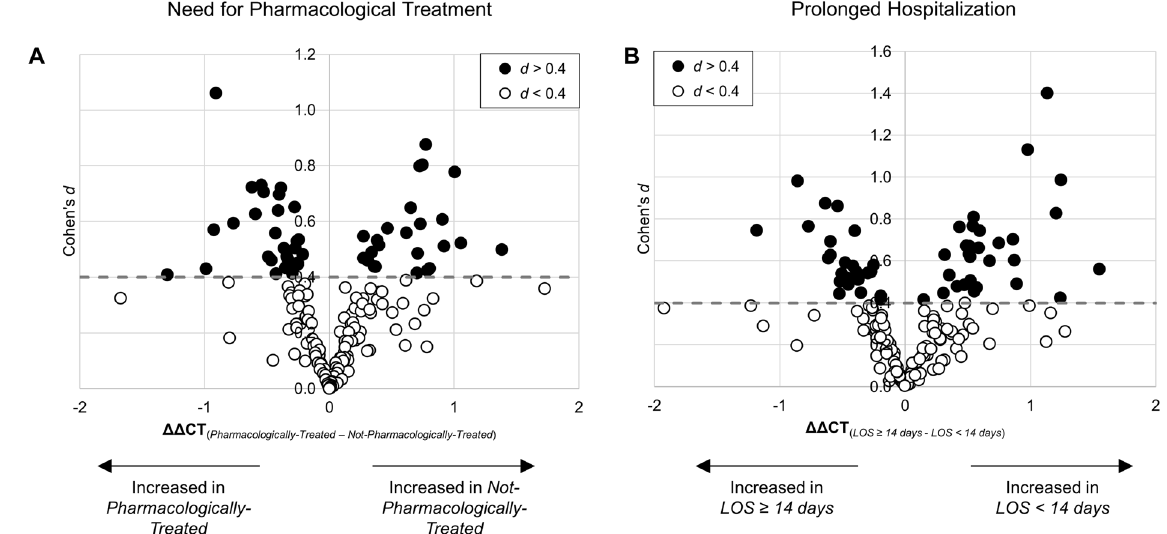
Figure 1. miRNA Expression in Infants with NOWS Requiring Pharmacologic Treatment or Prolonged Hospitalization. Volcano plots of cord blood plasma extracellular miRNA expression (difference in normalized CT between groups, ΔΔCT) and effect size (Cohen’s d ) comparing miRNA expression in neonates Pharmacologically-Treated compared to Not-Pharmacologically-Treated ( A ) and in LOS ≥ 14 days compared to LOS < 14 days neonates ( B ). White filled points denote miRNAs altered with a small effect size ( d < 0.4), black filled points denote miRNAs with moderate or larger effect size ( d > 0.4), and dashed line denotes d =